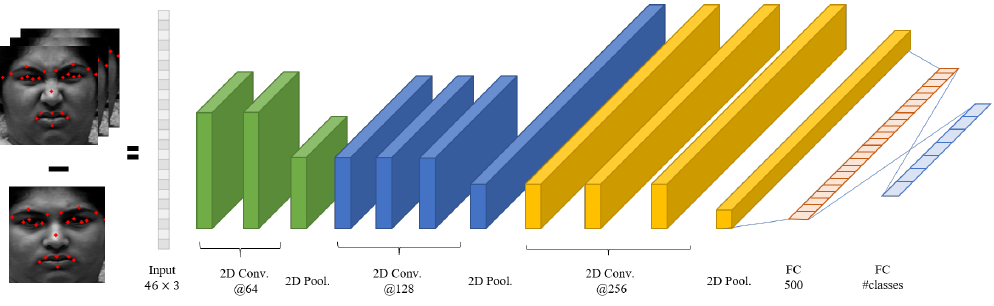
Figure 11. Geometric feature-based network.